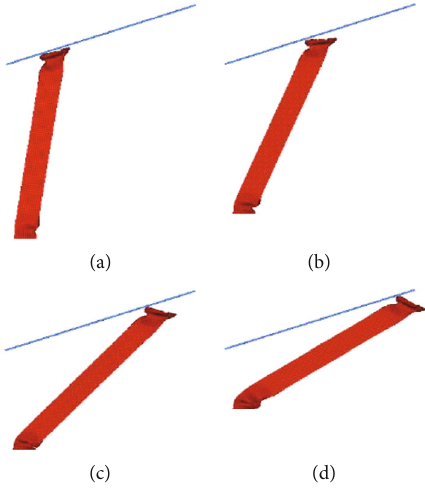
Figure 31: The deformation history of uniform thickness